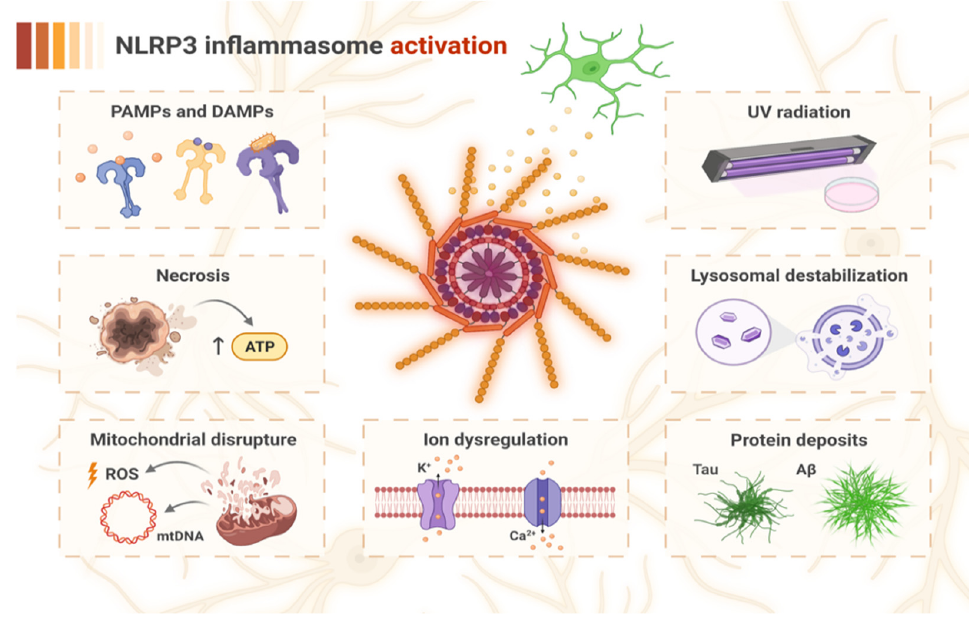
Figure 2. The factors inducing NOD-like receptor pyrin domain-containing 3 (NLRP3) inflammasome activation in the pathogenesis of AD. The recognition of pathogen-associated molecular patterns (PAMPs) and damage-associated molecular patterns (DAMPs) by specific cellular receptors may bring NLRP3 into the active state. Activation may also be triggered by factors related to cell damage, which involve mitochondrial disruption with the overproduction of reactive oxygen species (ROS) and mitochondrial DNA (mtDNA) release, necrosis with an increased level of ATP released from damaged cells, ion dysregulation (K + efflux and Ca 2+ influx), and lysosomal destabilization resulting from impaired microglial phagocytosis. Furthermore, protein deposits of Tau and amyloid β (A β ) may drive lysosomal dysfunction due to their resistance to degradation, and may also directly induce NLRP3 activation. Additionally, UV radiation constitutes another independent factor for activation of the NLRP3 inflammasome.